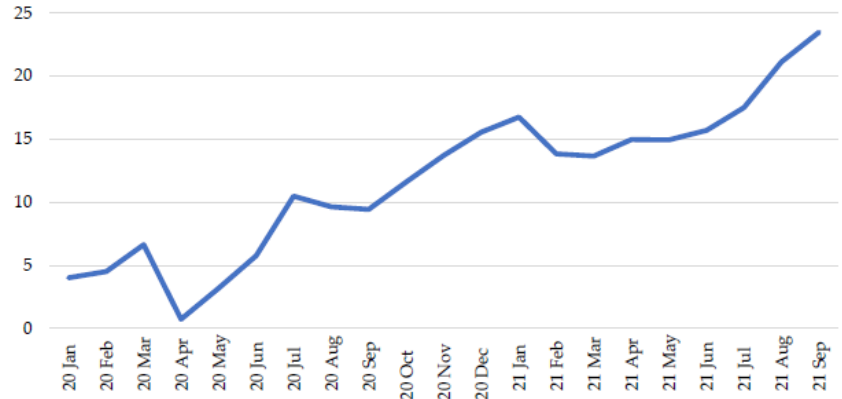
Figure 2. Number of Days per Month in Which More than 70 Percent of a State’s Beds Are in Use, Averaged over 50 States. Source: (COVID-19 Reported Patient Impact and Hospital Capacity by State Timeseries 2021).